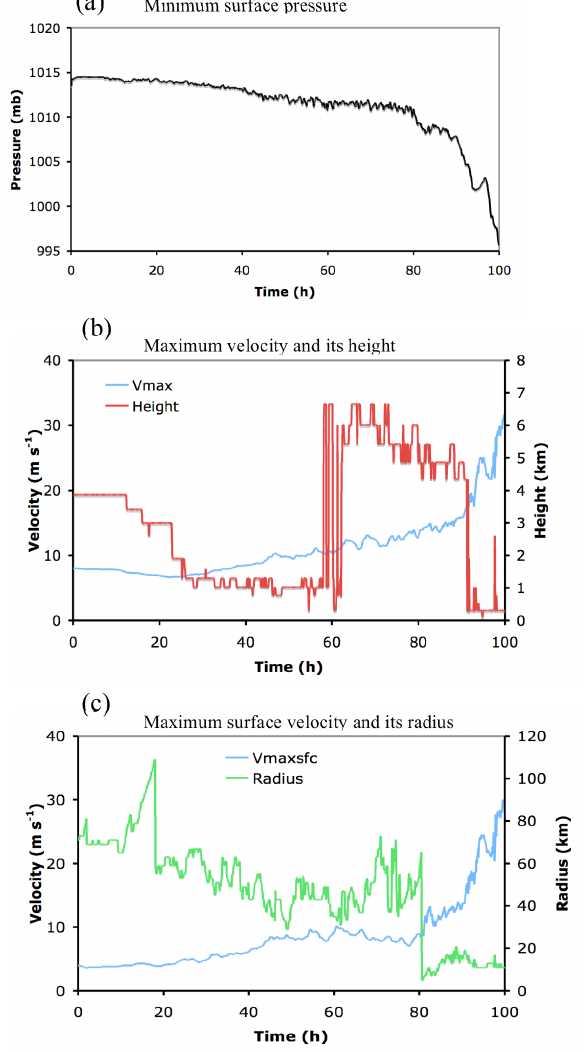
Fig. 4. As in Fig. 2, for Experiment Figure 4. As in Figure 2, for Experiment 2.